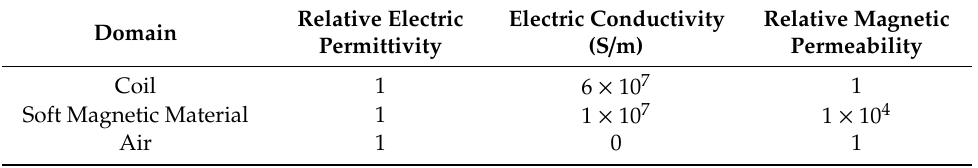
Table 2. Electric and magnetic properties of the electromagnetic actuator components [19,20].